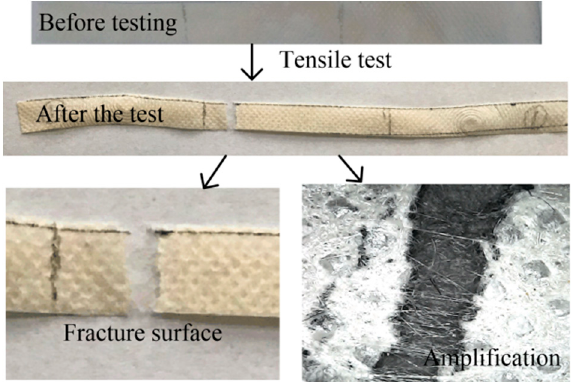
Figure 2. Samples before and after the tensile test.